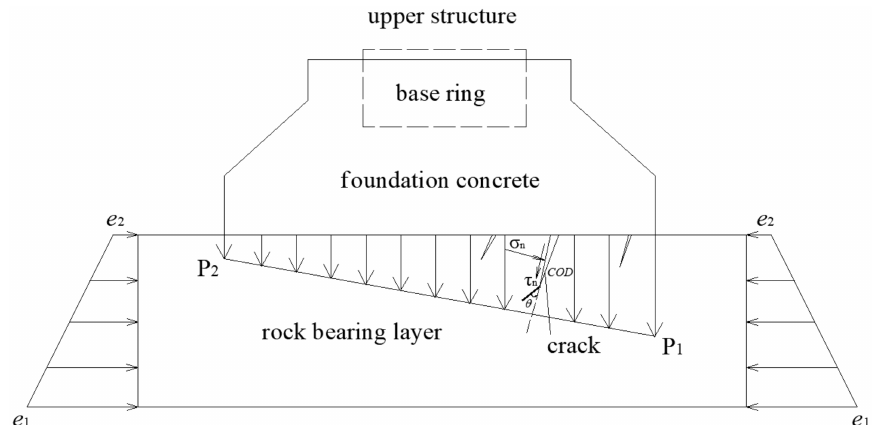
Figure 3. Crack expands and deforms under